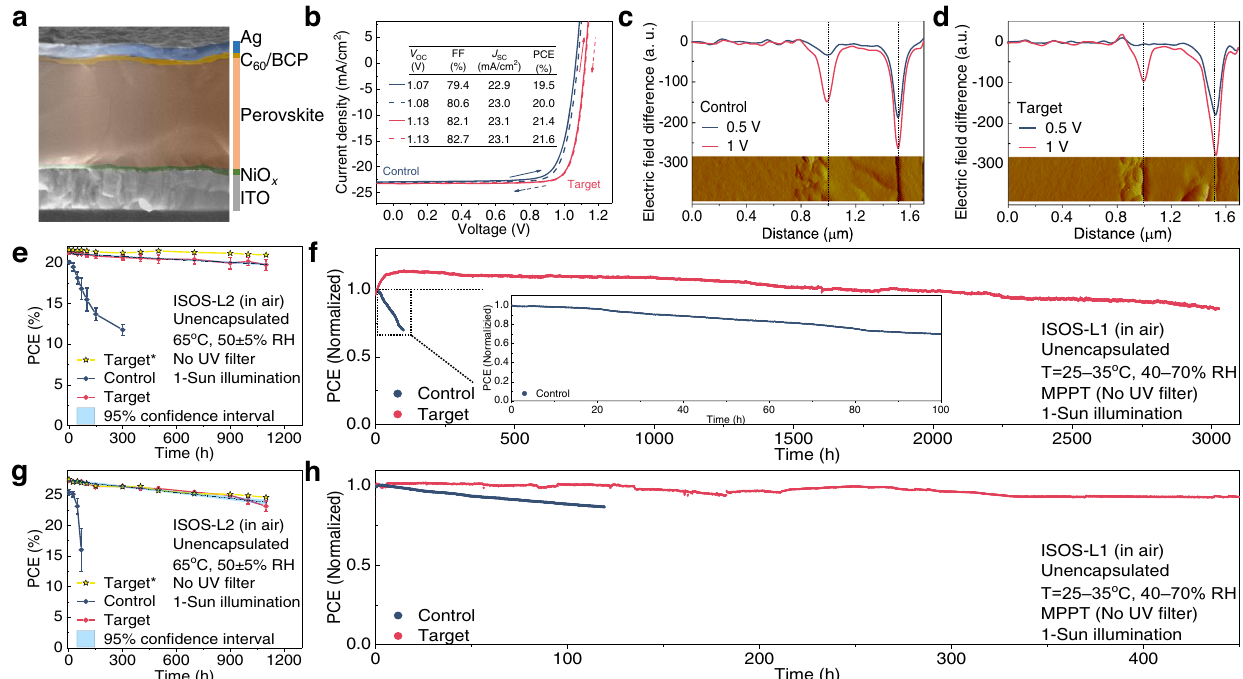
Fig. 4 | Device performance and stability. a Cross-sectional SEM image of the single-junction PSC. b J – V curves of the best-performing control (navy) and target (red)devices,inforwardscan(solidlines)andreversescan(dottedlines).Theinset table shows the corresponding ef fi ciency parameters. c , d AFM cross-section images(inset)andelectric fi elddifferencesacrossthewholecontrol( c )deviceand target ( d ) device, taken by the fi rst derivative in potential differences with respect to the zero bias. e ISOS-L2 measurements of unencapsulated devices. The target champion cell (denoted with*) is indicated with yellow stars (surrounded by black border lines). Standard deviation (error bar) is calculated from six individual